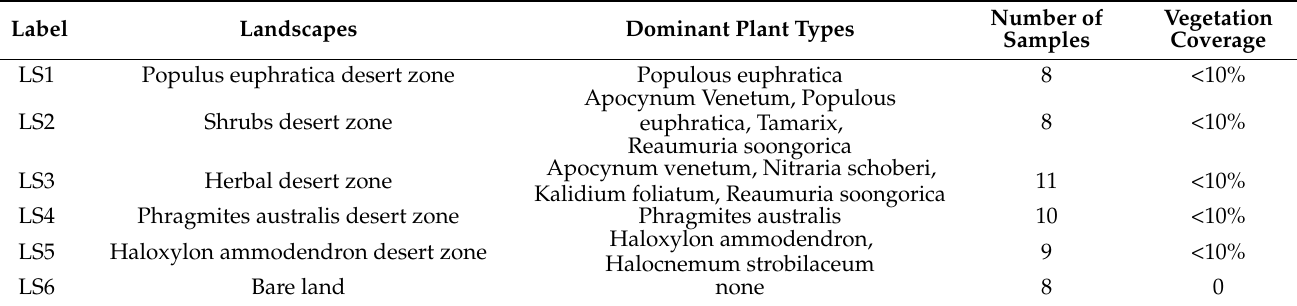
Table 1. Landscape types and number of